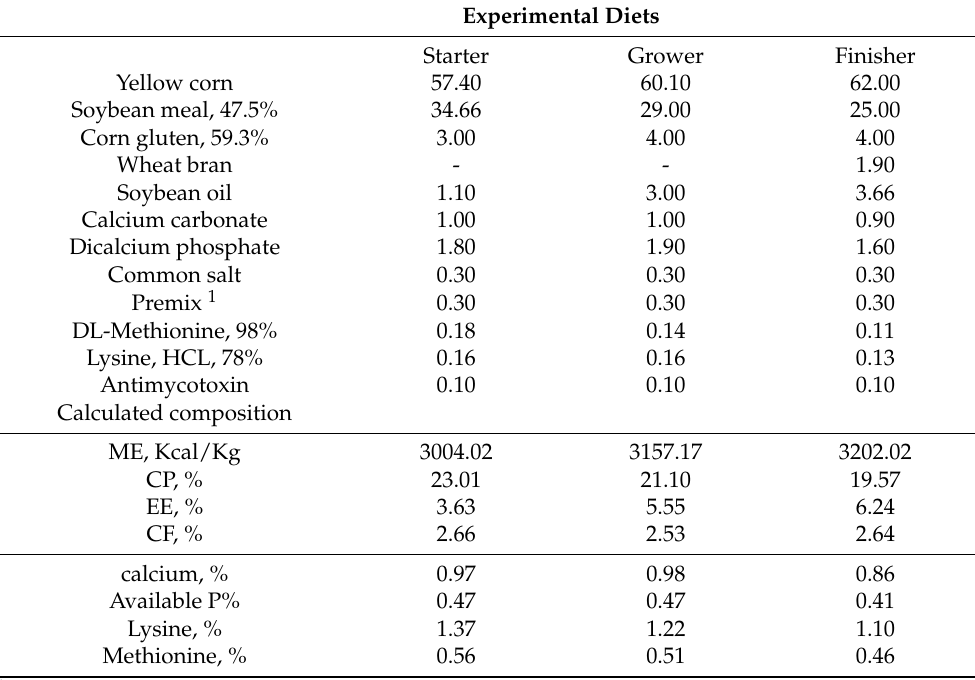
Table 1. Composition of experimental